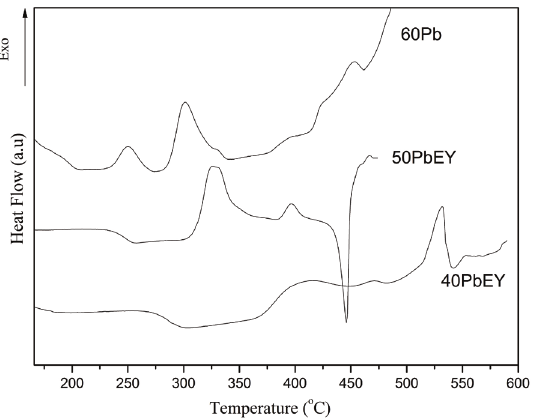
Figure 3. X-ray diffraction patterns of sample 40PbEY heat-treated at 400ºC for 30 min, 520 °C for 4 hours and crystalline F(PO ) reference. Pb 5 4 3